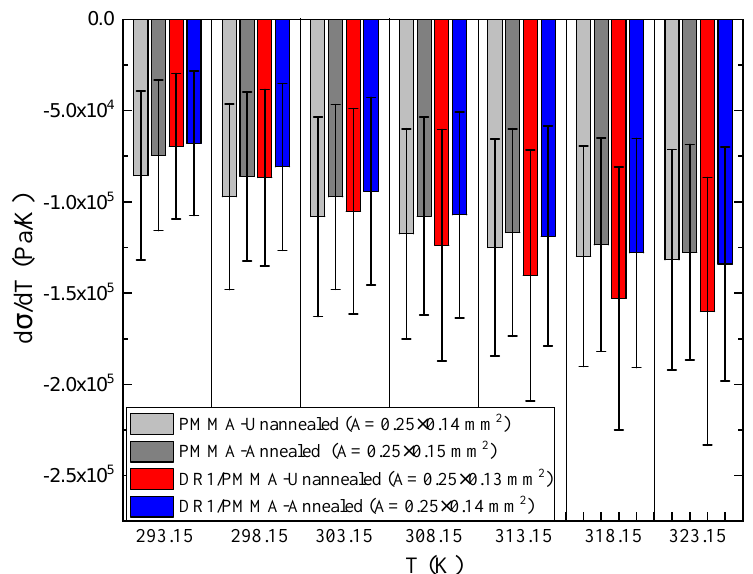
Figure 7. The stress derivative as a function of temperature for PMMA and DR1/PMMA fibers that are unannealed and